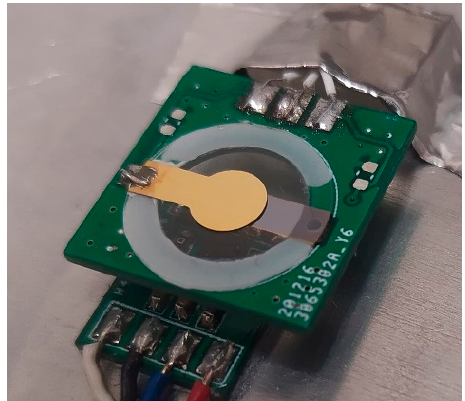
Figure 3. QCM mounted on proposed custom PCB holder.